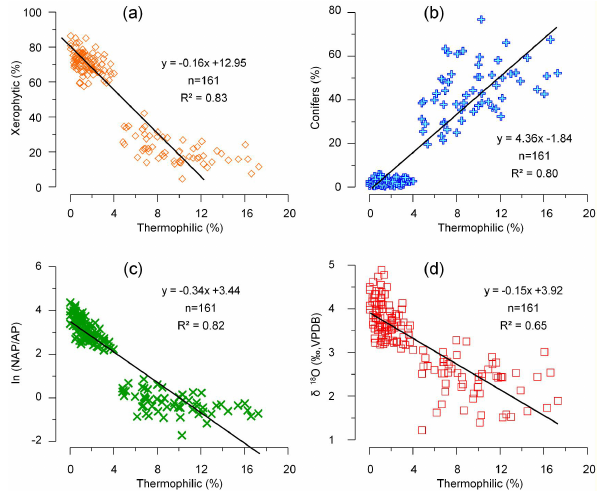
Fig. 8. Correlation between (a) xerophytic percentages and ther- mophilic percentages, (b) coniferous percentages and thermophilic percentages, (c) ln (NAP/AP) and thermophilic percentages, and (d) δ 18 O‰ (data from Zachos et al., 2008) and thermophilic percent-